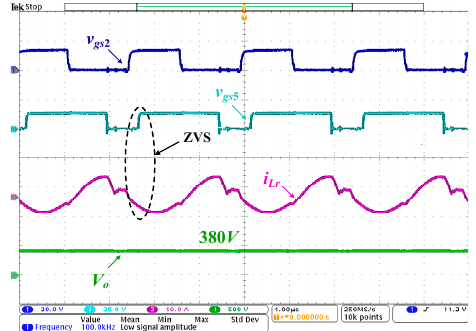
Figure 9. D Vgs5 = 0.85, R L = 50 ohm, Vo = 380 V, f s = 100 kHz.